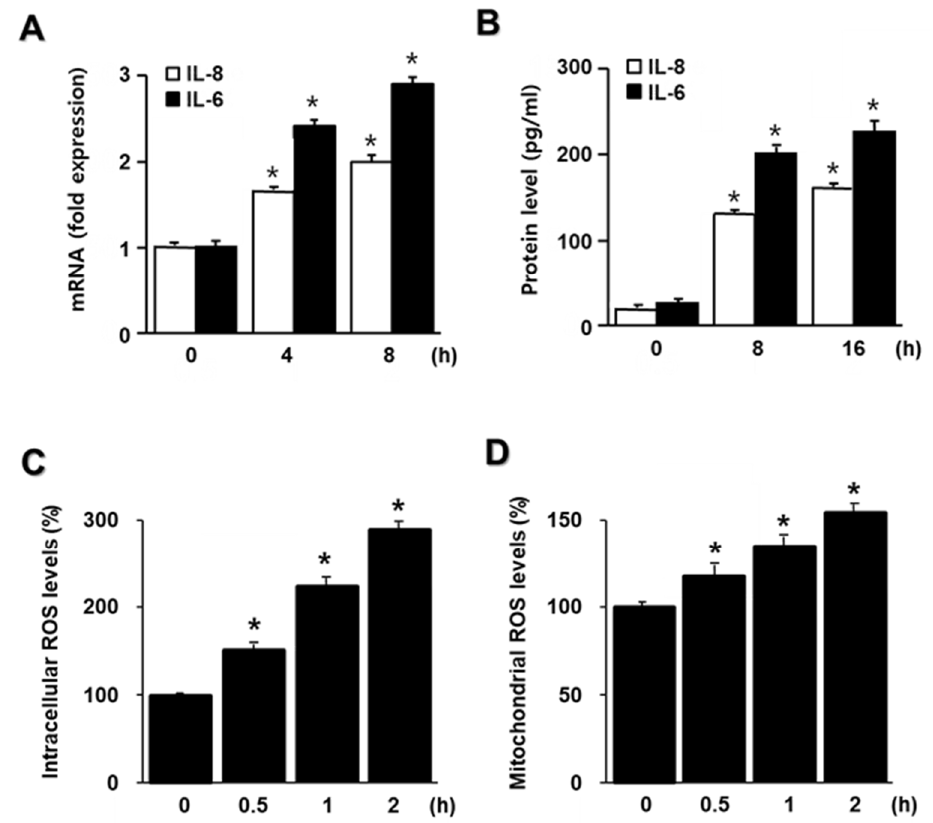
Figure 1. IL-6 and IL-8 mRNA and protein expression and intracellular and mitochondrial levels of ROS upon treatment with house dust mites (HDM). Cells were treated with 20 μ g/ml HDM for the indicated time periods. ( A ) mRNA expression of IL-6 and IL-8 was determined with reverse transcription-polymerase chain reaction (RT-PCR) analysis. The mRNA levels at 0 h were set as 1. ( B ) IL-6 and IL-8 protein levels in the medium were determined with enzyme-linked immunosorbent assay (ELISA). ( C ) The intracellular ROS levels were determined using DCF-DA. ROS levels of the cells at 0 h were set as 100%. ( D ) The mitochondrial ROS levels were determined using MitoSOX. ROS levels of the cells at 0 h were set as 100%. All data are shown as the mean ± S.E. of three independent experiments. * p < 0.05 versus 0 h.